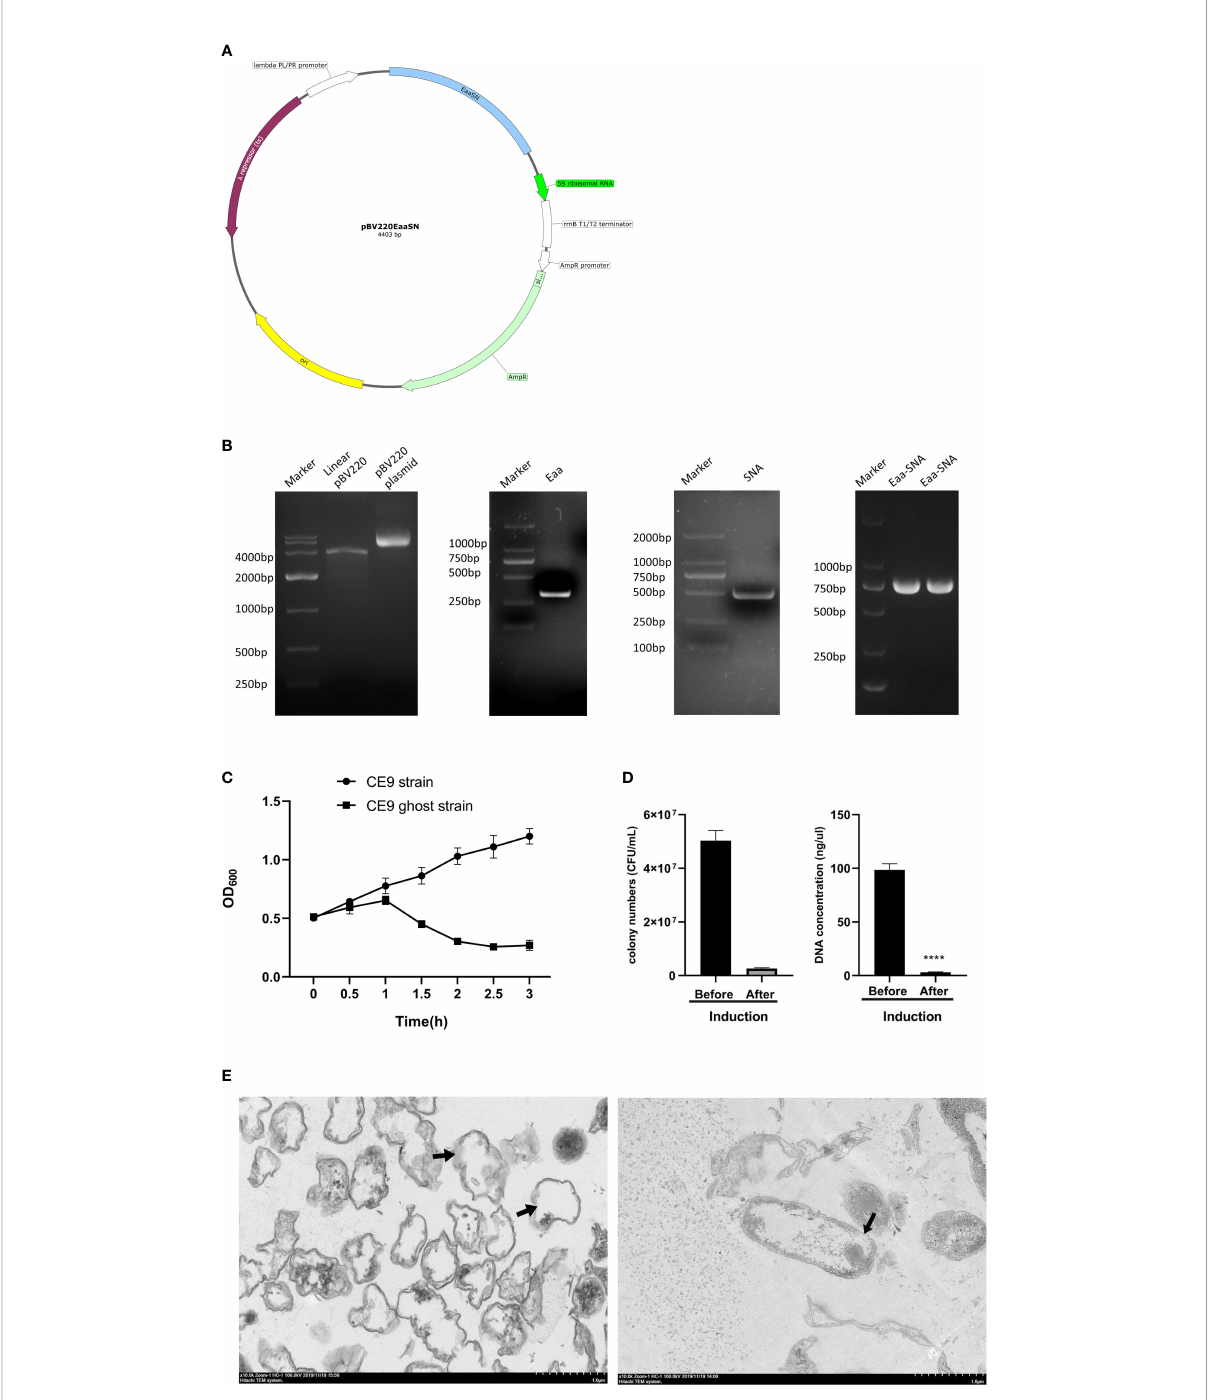
FIGURE 1 Construction of the lysis plasmid and identi fi cation of bacterial ghosts (BGs) quality. (A) The lysis plasmid map showing the location of elements with different colors. (B) PCR identi fi cation of E-lysis gene, SNA gene, and tandem fragments E-aa-SNA. (C) . The growth of CE9 strain and CE9 ghost strain (containing lysis plasmid) culturing at 42°C. (D) The lysis ef fi ciency was indicated by the number of clones and DNA concentrations before and after lysis. (E) Transmission electron micrographs of the BGs.